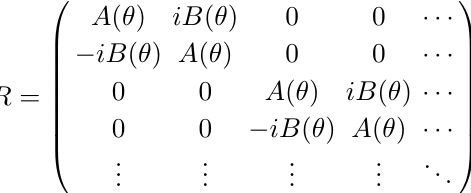
Figure 3 . Extended region of analyticity. We considered two cases: b 1 = 0 , π b 1 = π − b 2 , b 2 > π . It might seem that in the first case analyticity is guaranteed by crossing but this is not so because of the non-trivial crossing equation